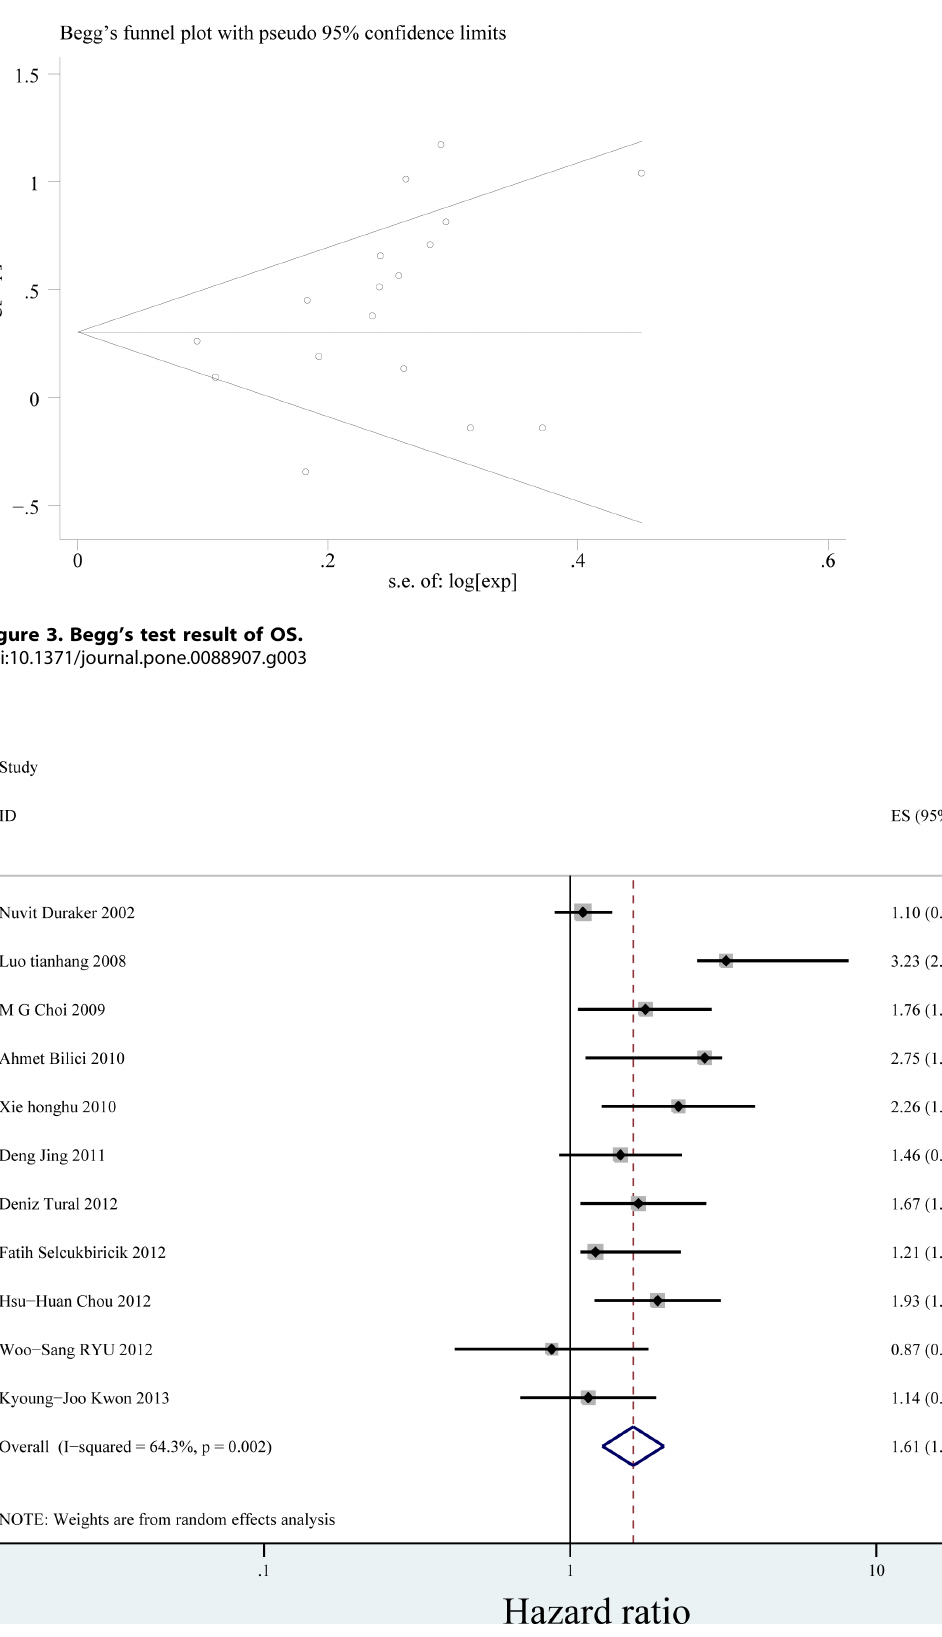
Figure 4. Forrest plot of combined hazard ratio for the association of PNI and OS of Asian in multivariate analysis.